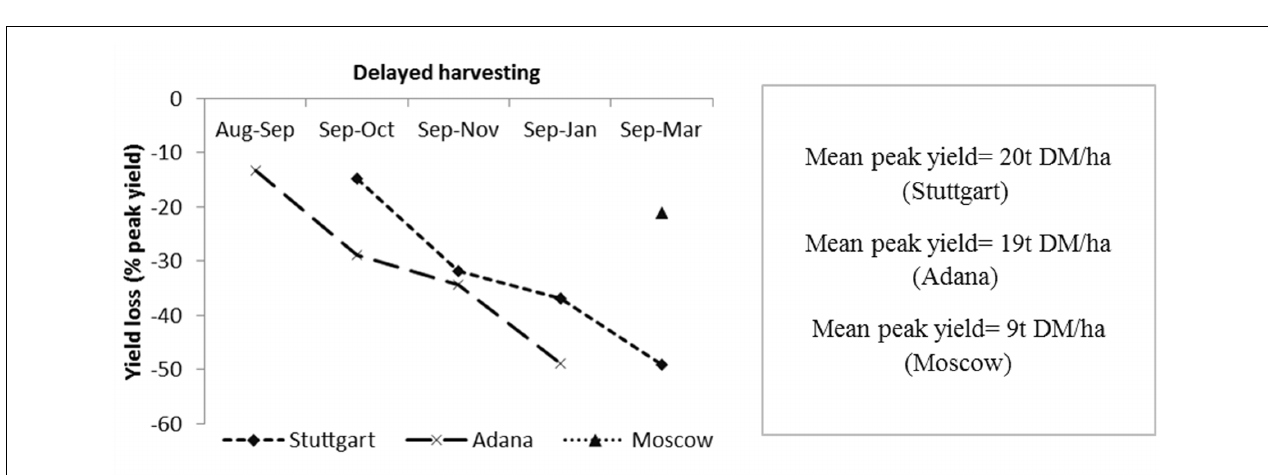
FIGURE 4 | Values of ash sintering index (Na + K/Ca + Si) for each genotype and harvesting time at Stuttgart, Adana and Moscow. Double asterisks ( ∗∗ ) indicate a highly significant impact ( P = 0.05) of interaction between harvesting time, genotype, and site whereas “ns” indicates that effect was not significant.